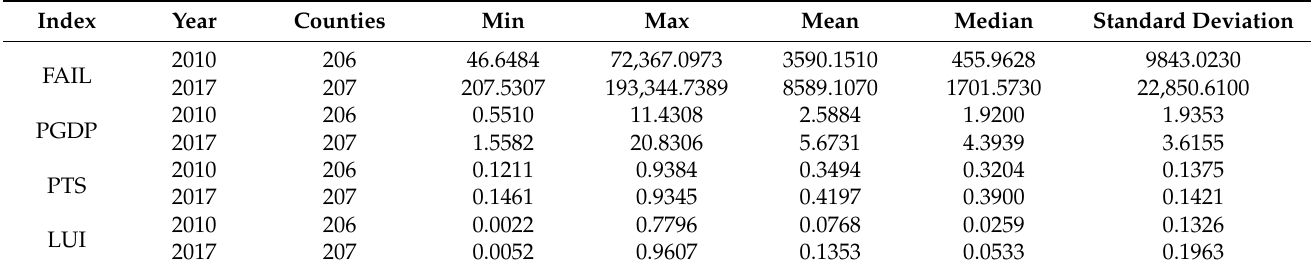
Table 2. Descriptive statistics in 2010 and 2017.